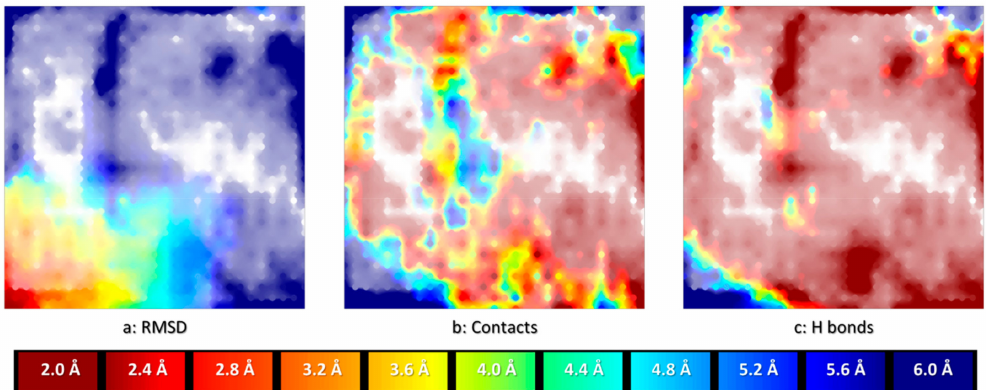
Figure 1. Aligned landscapes of the CF map, on which the docked ensemble of conformers of 1CKP was projected. The local density of residing conformers modulates color transparency and is the same in all plots. a : RMSD landscape–quantitative landscape with color encoding the RMSD of the poses with respect to the native structure (red = native-like zone, RMSD < 2Å, blue = non-native poses, RMSD ≥ 6Å, see spectrum bar below). b : fuzzy classification landscape overlapping the subpopulations of poses in which both key atoms (carbonyl O and amide H) of Leu 83 are simultaneously within direct contact distance to at least one of the ligand atoms (blue) versus poses in which at least one of the two key atoms is far from any ligand moiety (dark red), intermediate colors signaling that these subpopulations coexist in these “transition” areas. c : fuzzy classification landscape similar to ( b ), but specifically checking the satisfaction of a bidentate hydrogen bonding pattern to Leu